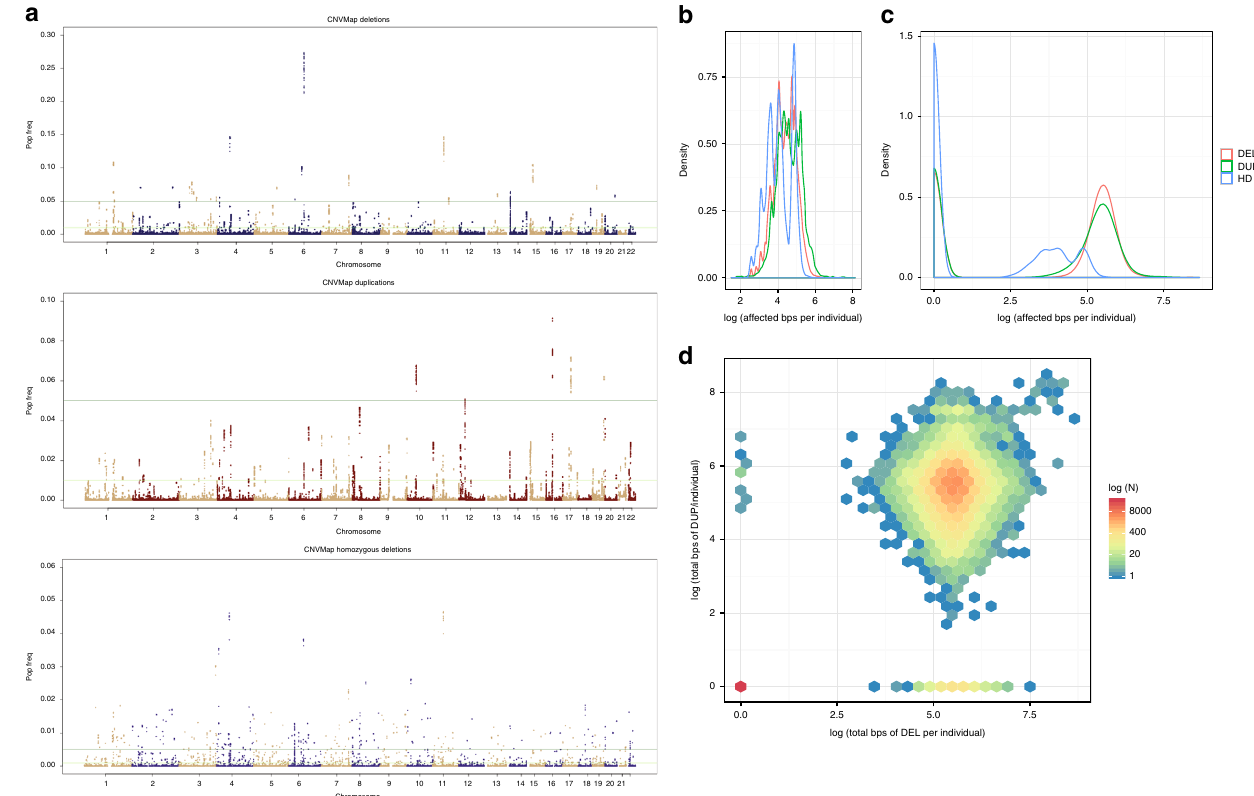
Fig. 1 Genome-wide frequency and distribution of CNVs. a “ Manhattan plot ” showing the distribution of identi fi ed CNVs across the genome with genomic positions across the x -axis, including deletions (left), duplications (center), and homozygous deletions (bottom) with the y -axis showing observed frequency of each CNV in the total study population. b Histogram of duplication, deletion, and homozygous deletions frequencies for all identi fi ed CNVs as a function of total CNV burden per individual (in bps on a log10 scale). c Histogram of duplication, deletion, and homozygous deletions frequencies as a function of total CNV burden (in bps on a log10 scale) per individual. d Density plot showing each individual ’ s deletion burden (in bps on a log10 scale) plotted against that same individual ’ s duplication burden (in bps on a log10 scale). Individuals with the same event burden (bps affected) are binned into hexagon and the color correlates with the total count of individuals in each bin, re fl ecting that most individuals who have more duplications also have more deletions; however, there are some exceptions in patients with relatively large burdens of deletions or duplications without comparable burden of the